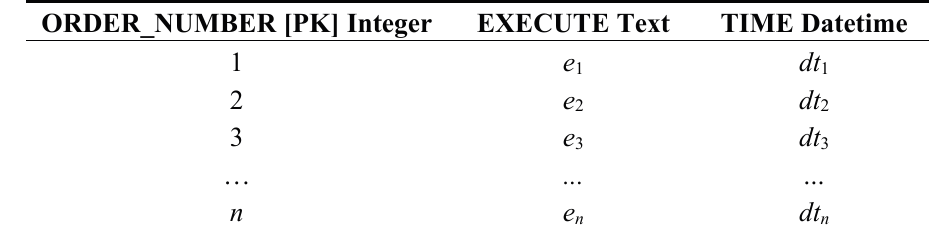
Table 4. Database table that stores execution statuses of sensor and sensor platform data collection